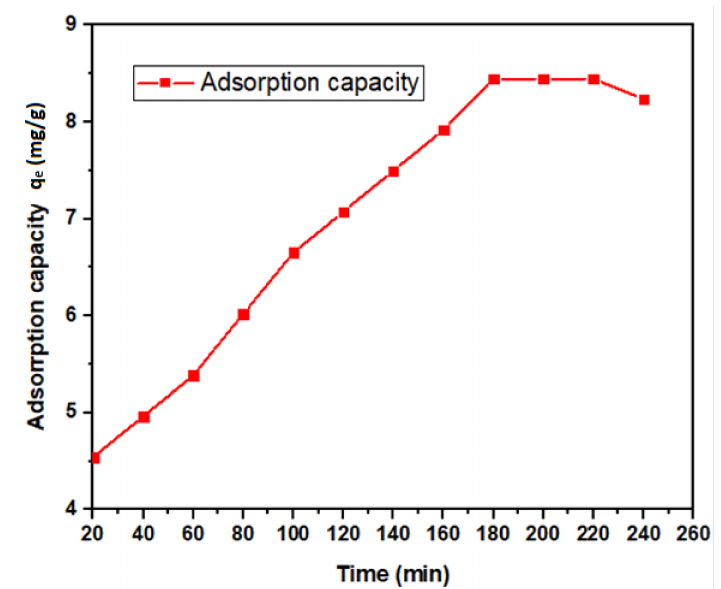
Figure 8. Boron adsorption capacity by nano-magnetite under variable contact times (20–240 min) at fixed dosage (0.5 g) and pH (8).